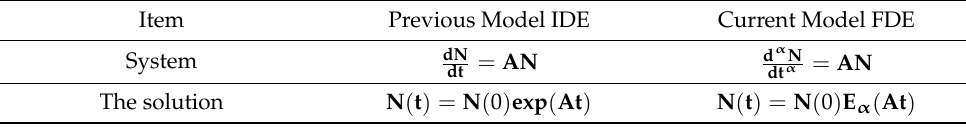
Table 2. Modification of current model from previous